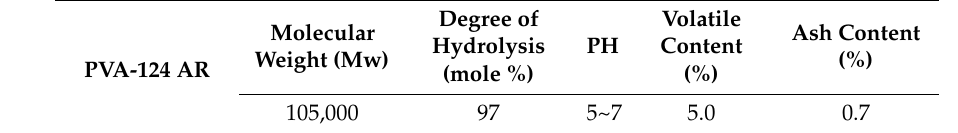
Table 2. Physicochemical characteristics of PVA.